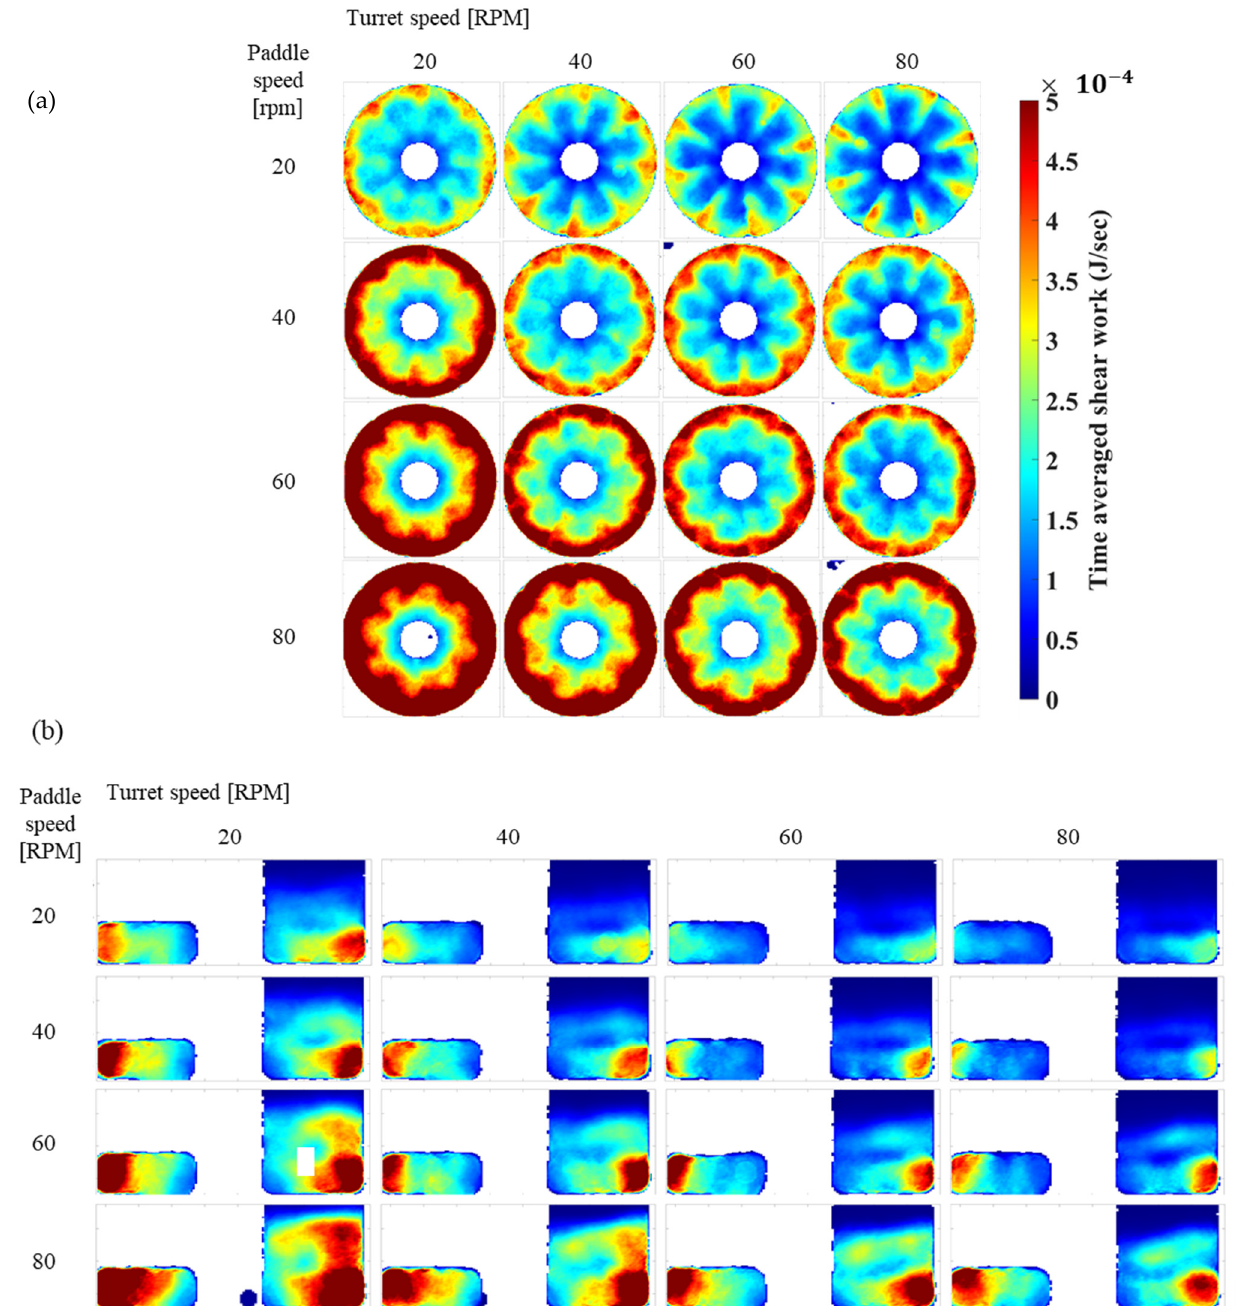
Figure 10. Continuous spatial plots showing time averaged (over 30 s) particle shear work done in the feed frame where each column corresponds to a different turret speed and each row corresponds to a different paddle speed: ( a ) top view plane at 16 different paddle and turret speeds; ( b ) side view plane at 16 different paddle and turret speeds (left: half of the chamber; right: half of the chamber and the hopper). Blue color indicates smaller shear work, and red color indicates larger shear work.